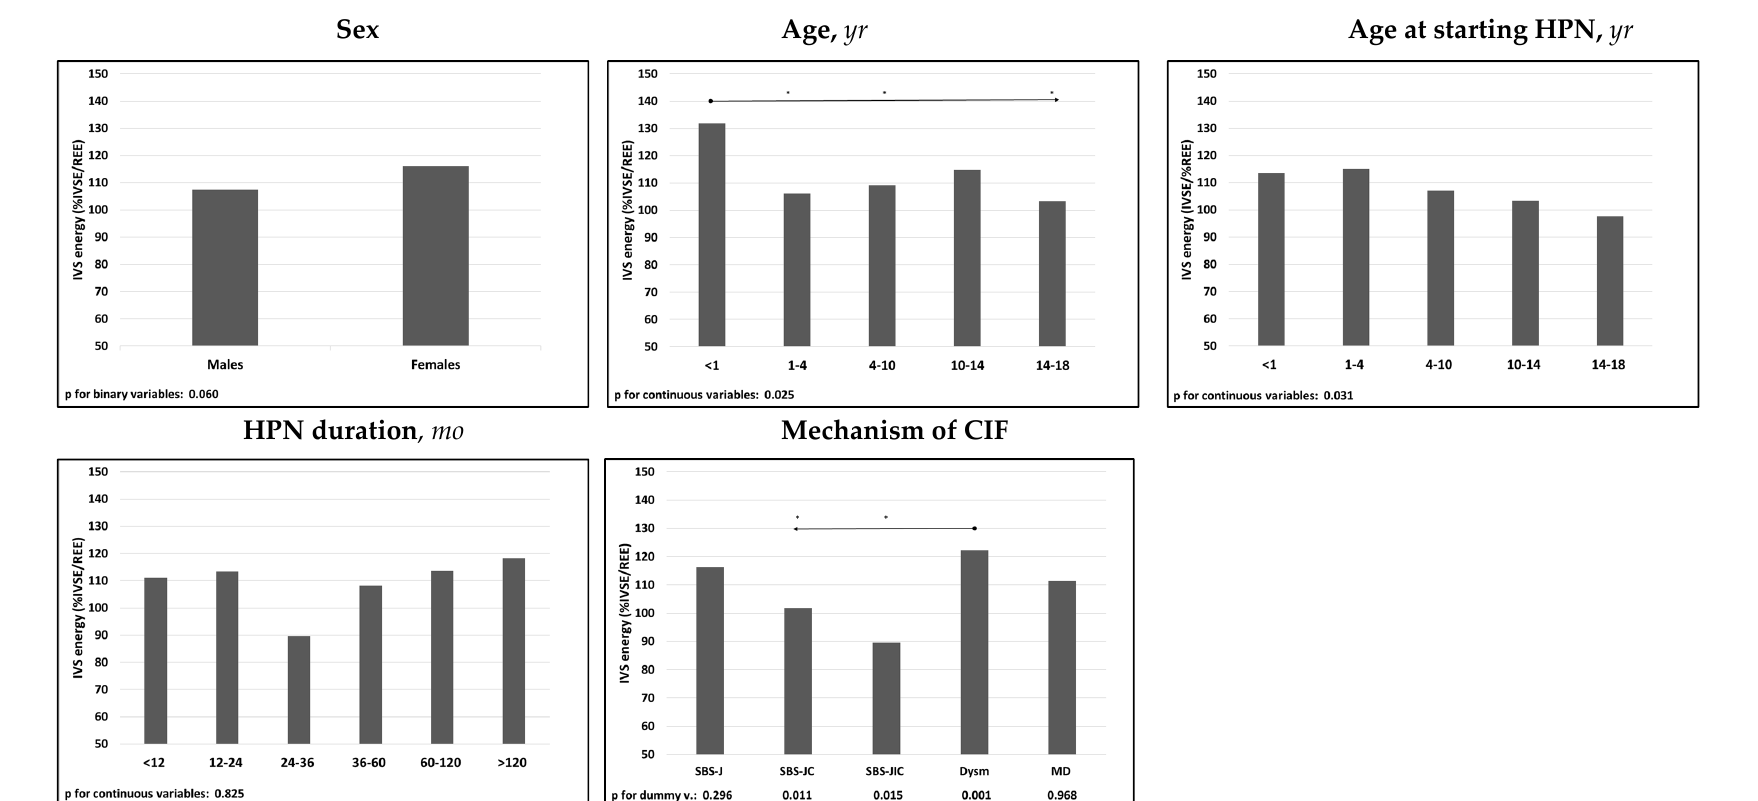
Figure 4. Associations of median IVS energy (%IVSE/REE) with patients’ characteristics. Spearman’s test was used for the continuous variables; Mann-Whitney’s test for the binary variable sex; The categorical variable “mechanism of CIF” was dichotomized and each dummy variable was analyzed individually; The relative effects between the categories of the ordinal variables were compared using the nonparametric multiple comparisons for relative effects test with Tukey’s test for the contrasts. * p < 0.05 between categories; direction of the comparison. Abbreviations: IVS energy (%IVSE/REE), ratio of daily intravenous supplementation total energy over estimated resting energy expenditure; HPN, home parenteral nutrition; CIF, chronic intestinal failure; SBS-J, SBS with end jejunostomy or ileostomy (also included enterocutaneous fistulas, n. 7); SBS-JC, jejuno-colic anastomosis; SBS-JIC, jejunoileal anastomosis with an intact colon and ileocecal valve; Dysm, dysmotility (also included patients with mechanical obstruction, n. 8); MD, mucosal